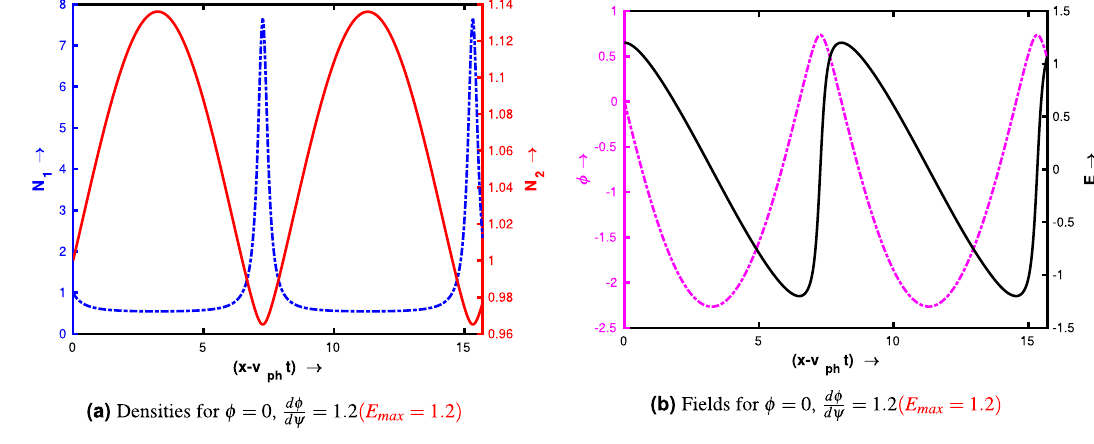
Figure 4. Profile of the wave for δ i = 0.9 , γ ph = 100 , β th , e = 0.3 , Q = 1 , µ = 20 and κ = 20